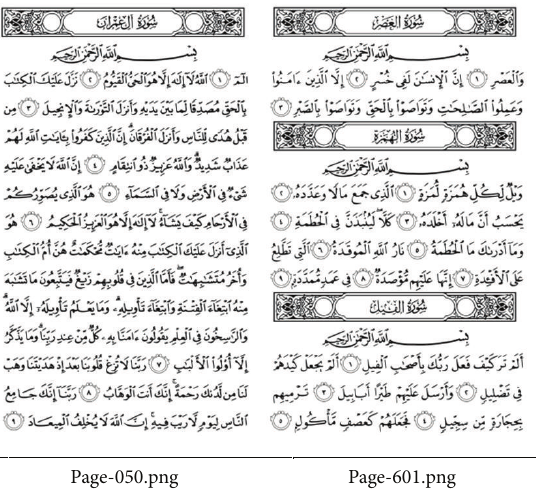
Figure 3: Some Quran images in the dataset.